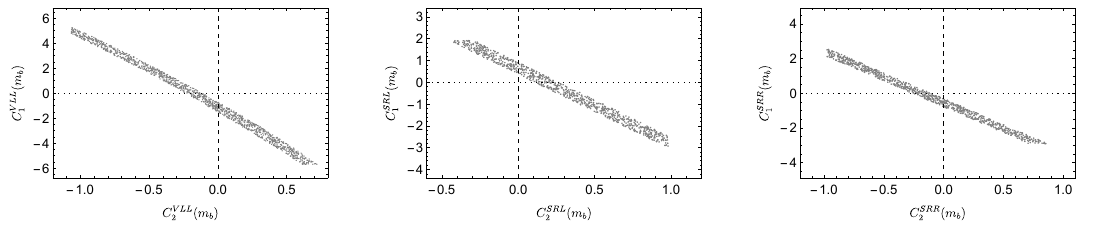
Figure 10 . Allowed regions in the ( C V LL ( m b ) , C V LL ( m b )) (left), ( C SRL 2 1 dle), and ( C SRR ( m b ) , C SRR ( m b )) (right) planes, under the combined constraints from the ratios 2 1 R ( ∗ ) varied within 2 σ error ( s ) L